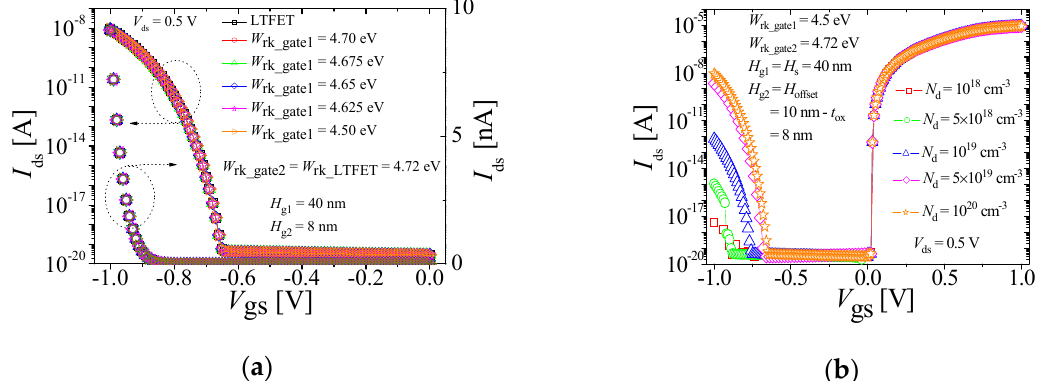
Figure 11. ( a ) I ds - V gs characteristics of DG-LTFET at V ds = 0.5 V with different W rk_gate1 and W rk_gate2 = W rk_LTFET , H g1 = H offset = 10 nm, H g2 = 8 nm, T j = 5 nm and N d = 10 20 cm − 3 . Red circles, green triangles, blue diamonds, magenta stars, and orange right triangles: W rk_gate1 = 4.7, 4.675, 4.65, 4.625, and 4.5 eV. ( b ) DG-LTFET I ds with different N d . N d = 10 18 cm − 3 demonstrates almost negligible ambipolar I ds . Red squares, green circles, blue triangles, magenta diamonds, and orange stars: N d = 10 18 , 5 × 10 18 , 10 19 , 5 × 10 19 , and 10 20 cm − 3 .